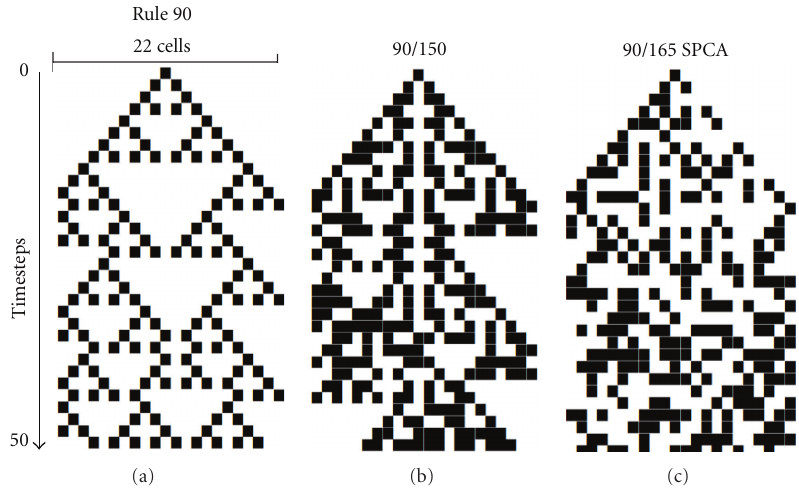
Figure 5: Space-time evolution patterns for: (a) a simple rule-90 CA, (b) a hybrid 90/150 CA, and (c) the SPCA using rules 90/165 and super-rule 90. All are initialized with a single bit in the center.